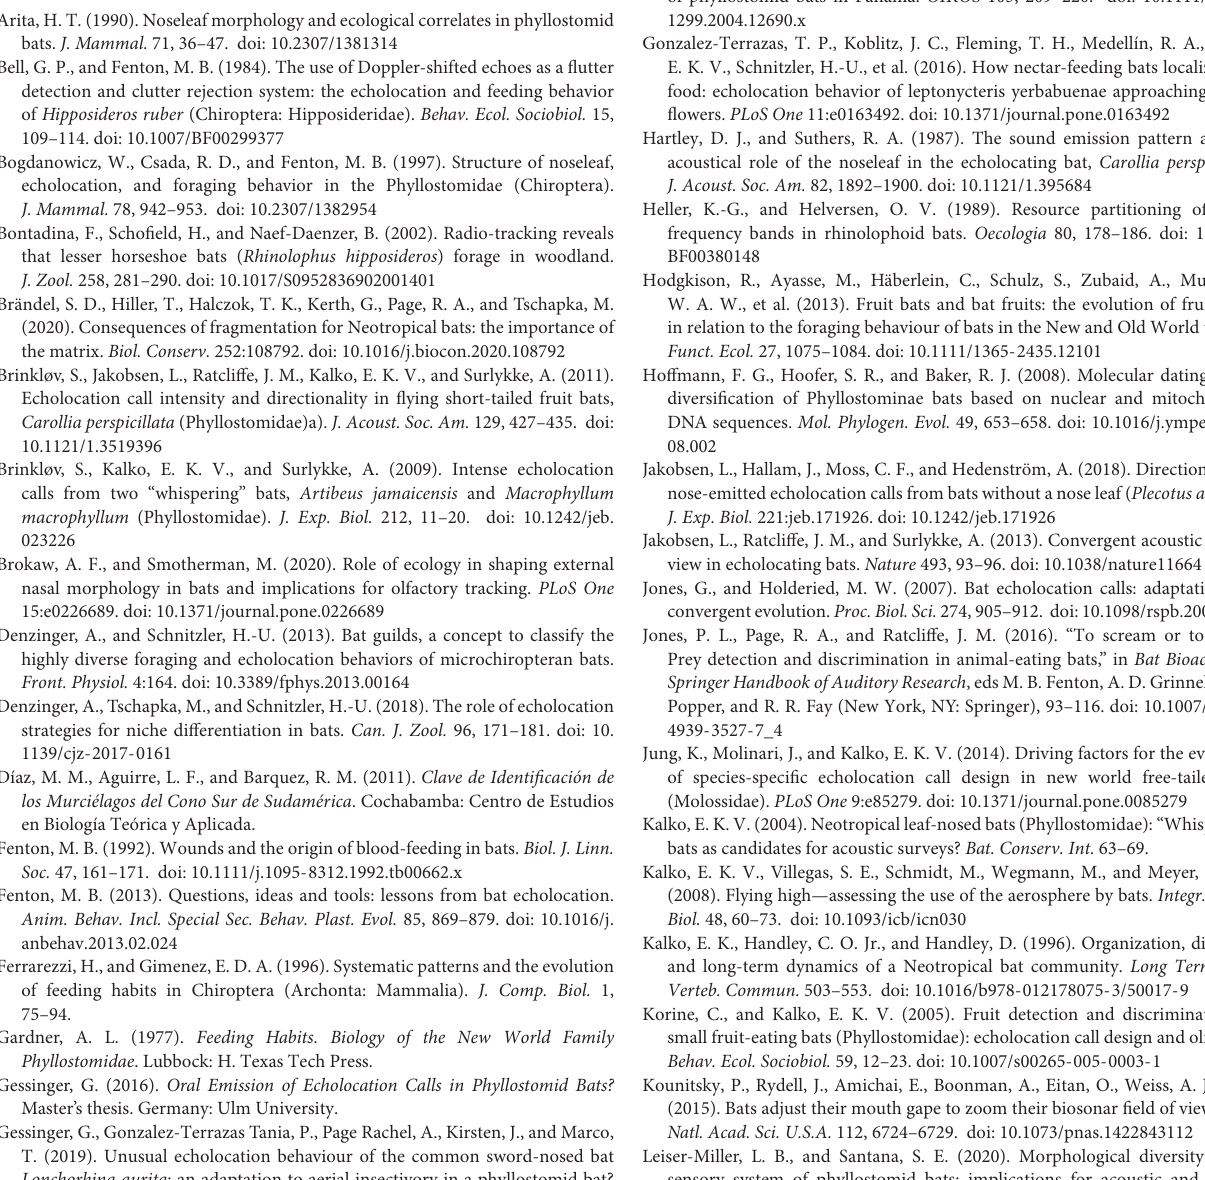
Supplementary Table 1 | Raw data of i. mouth posture, ii. gape and head position angle, iii. mouth posture of L. aurita during roost emergence. Supplementary Table 2 | Angle measurements and their digitalization errors. Supplementary Table 3 | Genbank sequence IDs of the sequences used for reconstructing the phylogenetic tree, modified from Rojas et al. (2016) and pers comm. Paul